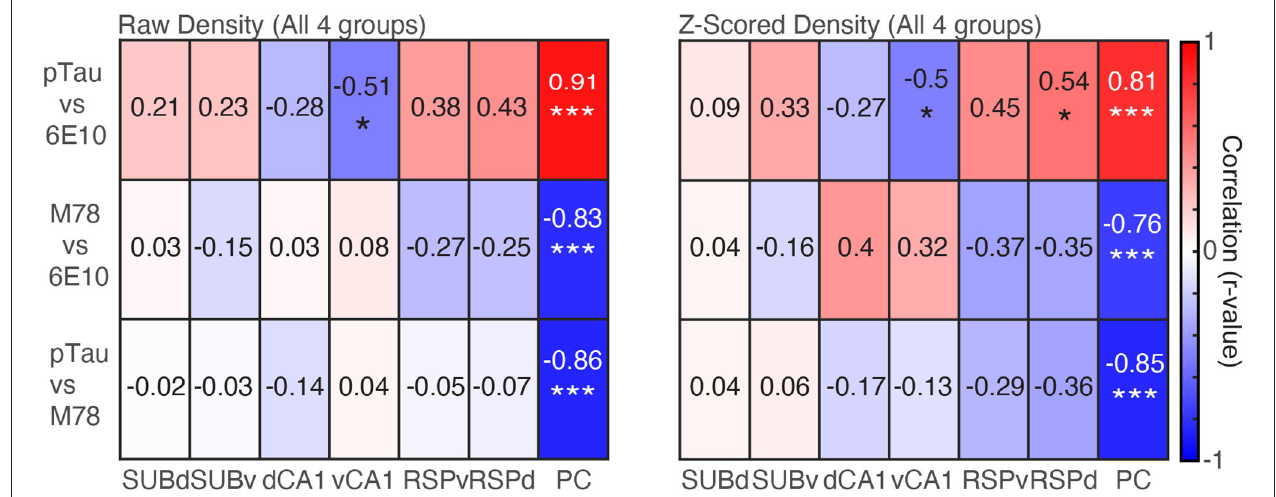
FIGURE 5 | Densities of pTau and 6E10 are positively correlated, while M78 is negatively correlated with both pTau and 6E10. Left . Raw density correlations for pairwise combinations of each marker of pathology (pTau, M78 and 6E10) for each of the seven brain regions. Right . Same as Left, but for Z -scored density data. * p < 0.05, *** p <